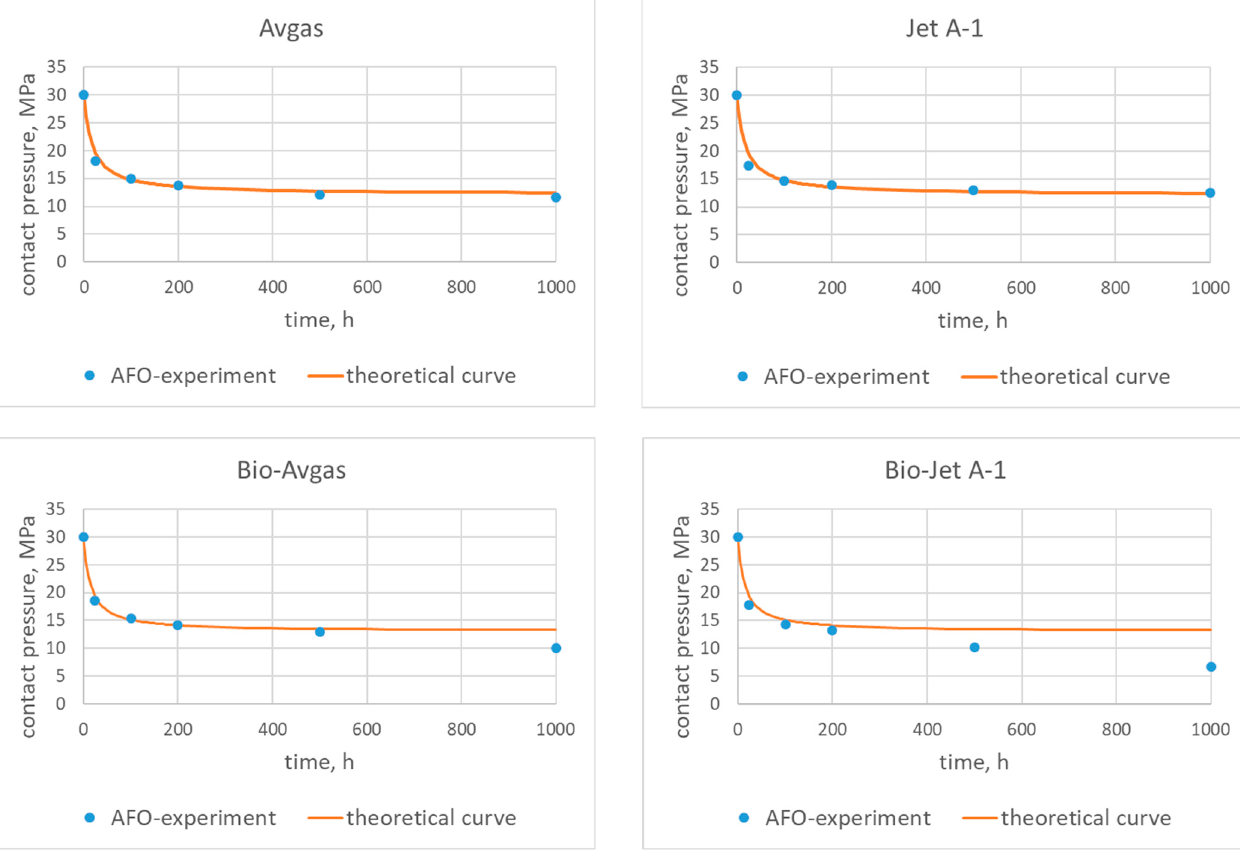
Figure 5. Contact pressure for the AFO gasket and the tested fuels—theoretical characteristics and experimental data.